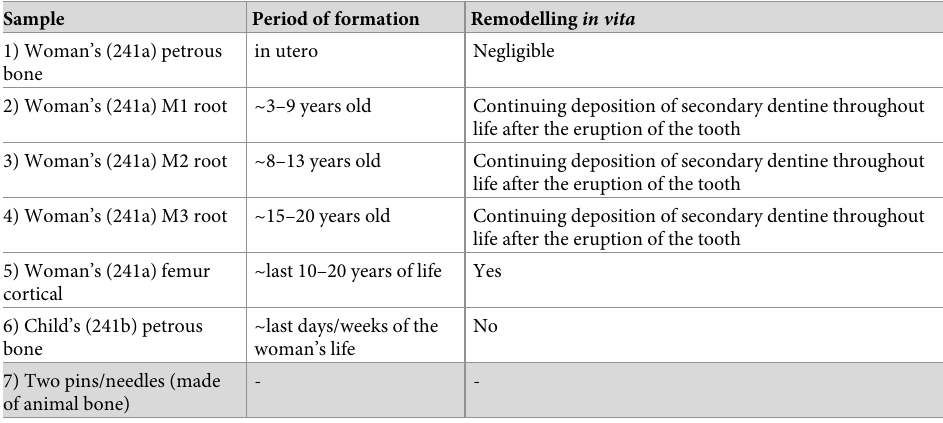
Table 2. Samples taken from burial 241 for 87 Sr/ 86 Sr analysis and period of formation of the dental/skeletal element. Sample Period of formation Remodelling in